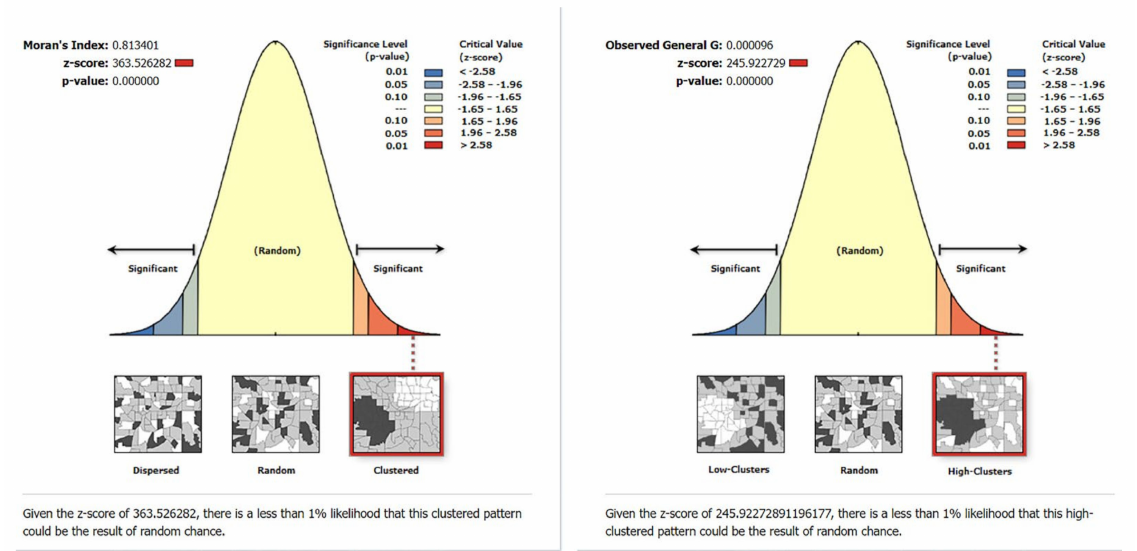
Figure 7. Global Moran ’ s I (Category- Ⅰ ); Getis – Ord General G (Category- Ⅰ ). For Category- Ⅱ , the Global Moran ’ s I analysis ( p -value < 0.00001, Z-score = 386.937068) and Getis-Ord General G ( p -value < 0.00001, Z-score = 285.052686) results indicate that the null hypothesis is denied, and show high-value agglomeration (Figure 8). From the global correlation analysis, it can be seen that both categories of elderly care facilities have spatial agglomeration, and the spatial agglomeration presents high-value clustering.